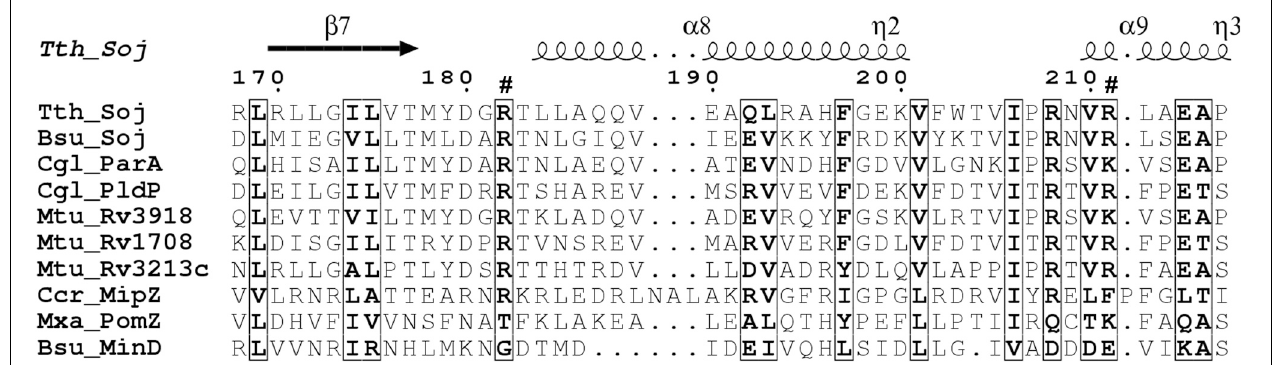
FIGURE 1 | Alignment of ParA proteins highlighting basic residues involved in DNA-binding. Surface exposed arginine residues have been shown to be involved in DNA-binding in B. subtilis Soj (Hester and Lutkenhaus, 2007). We have aligned sequence of different ParA/MinD proteins using ClustalW2. The alignment was rendered in ESPript (Gouet